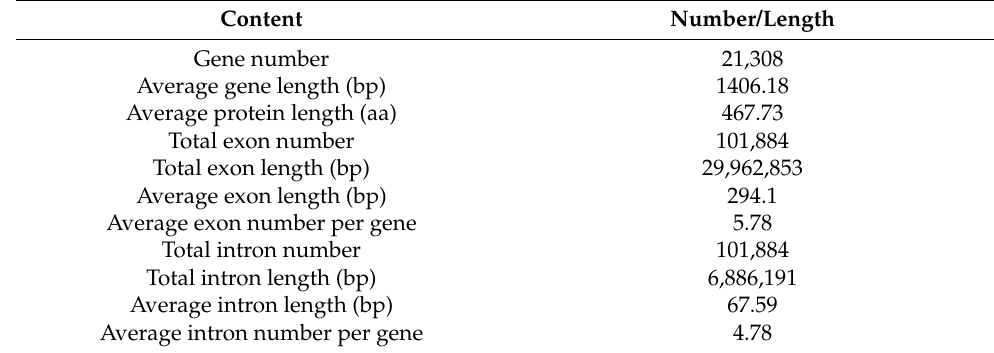
Table 3. Characteristics of the gene prediction of O. raphanipes